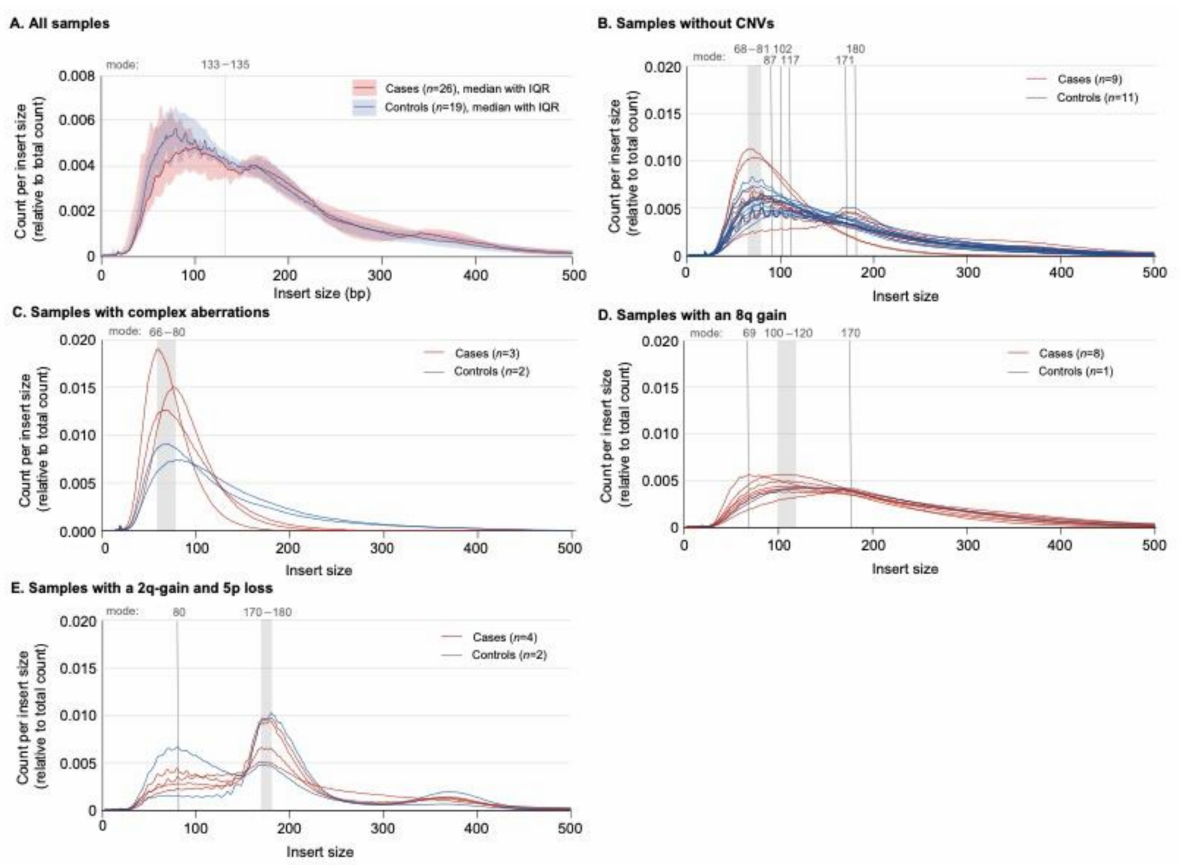
Figure 2. The fragment lengths’ (insert size) distributions in pancreatic juice (PJ) samples. ( A ) The cases (red) in comparison with the controls (blue); fragments with a length of 133–135 base pairs (bp) were more prevalent in the controls than cases ( p = 0.05; Mann–Whitney U). IQR = interquartile range. ( B ) Samples without a copy number variation (CNV) on the Wisecondor image. The peak prevalence varied between 65 and 117, 171 and 180 bp. Ten out of twenty samples had a sawtooth pattern (50%), which all showed a showed a second peak at 170–180 bp. ( C ) Samples with complex (chaotic) aberrations on the Wisecondor image. Each sample harbored mostly short fragments (mode 65–80 bp). The presence of short fragments and the complex (chaotic) aberrations may be related. ( D ) The samples from individuals with an 8q gain showed a similar graph with a moderate (or no) sawtooth pattern. Six out of eight individuals had a mode between 100 and 120 bp. ( E ) Samples with a 2p gain and 5q loss: each line shows two peaks (at ± 80 bp and 170–180 bp); the first peak has a clear sawtooth